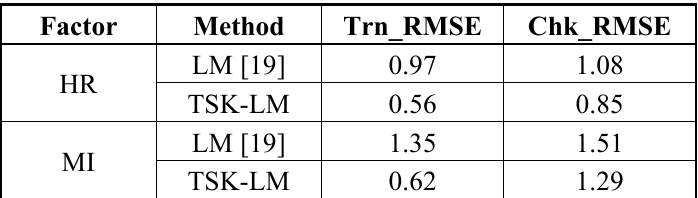
Table 3. Factor influence on prediction performance.